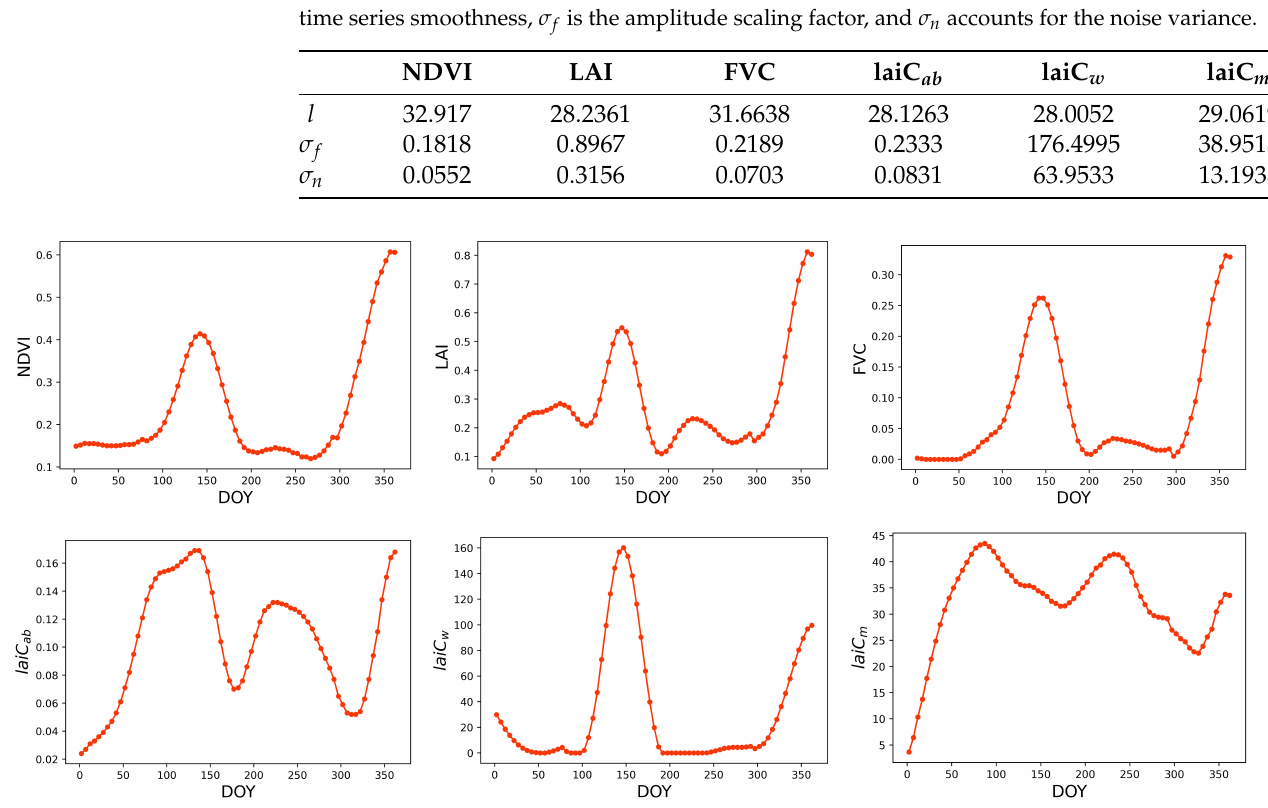
Figure A1. Time series profiles of crop traits for a wheat pixel presenting double